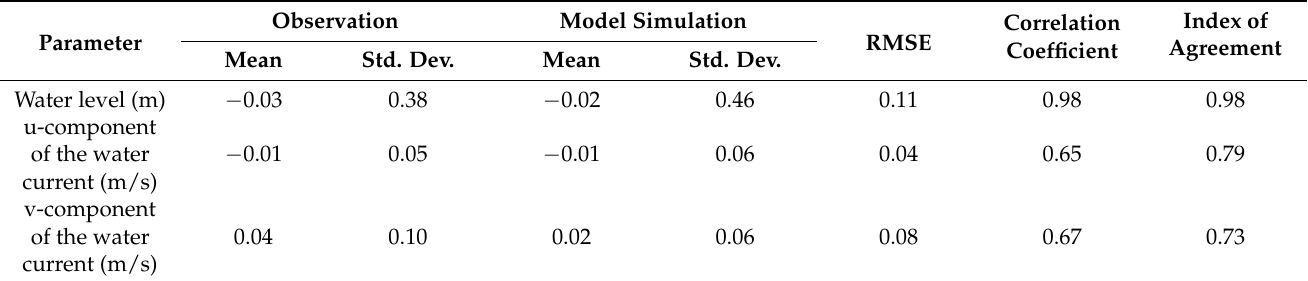
Table 1. Statistical assessment of the hydrodynamic model performance at S1 for the water level, and u and v components of the water current.